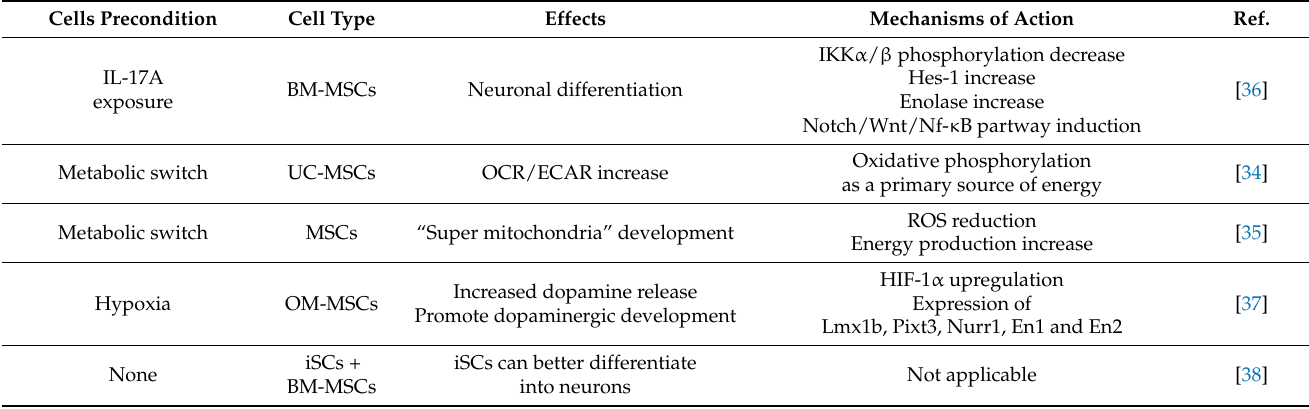
Table 1. Different preconditioning strategies to increase the beneficial potential of stem